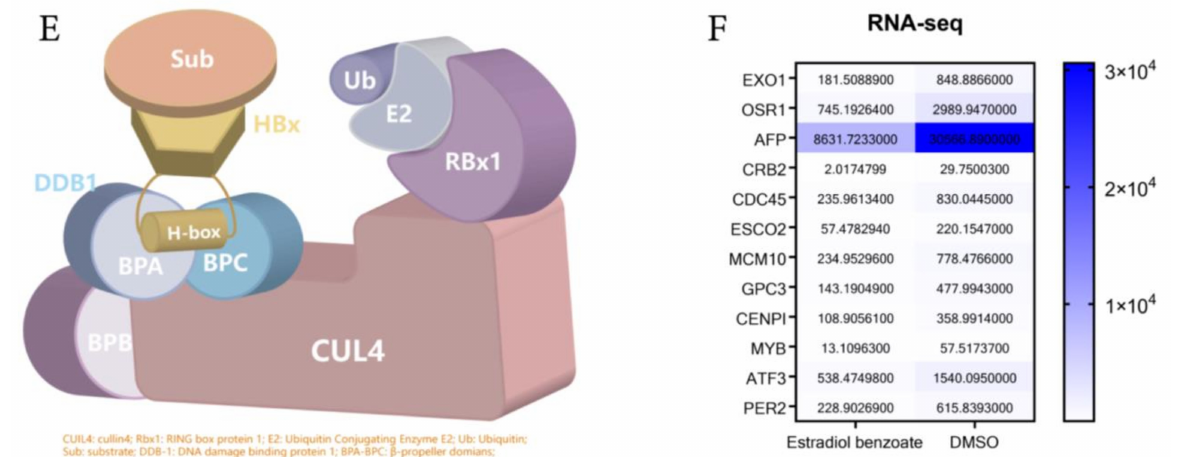
Figure 4. The model of estradiol benzoate and HBx interaction. ( A ) Chemical structures of estradiol benzoate and 17 β -estradiol. ( B ) Predicted model 1 of HBx protein using I-TASSER. ( C ) Predicted normalized B-factor of HBx illustrating the helix and strands of HBx. ( D ) The estradiol benzoate docking model with HBx. Estradiol benzoate binds with HBx at Tryptophan 87 and Tryptophan 107. ( E ) A schematic model of HBx and DDB-1 interaction. DDB-1 uses its BPB domain to bind with CLU4. HBx binds to DDB-1 BPA-BPC double propeller with its H-box motif. ( F ) RNA-seq counts to DDB-CUL4 related downstream genes after being treated with estradiol